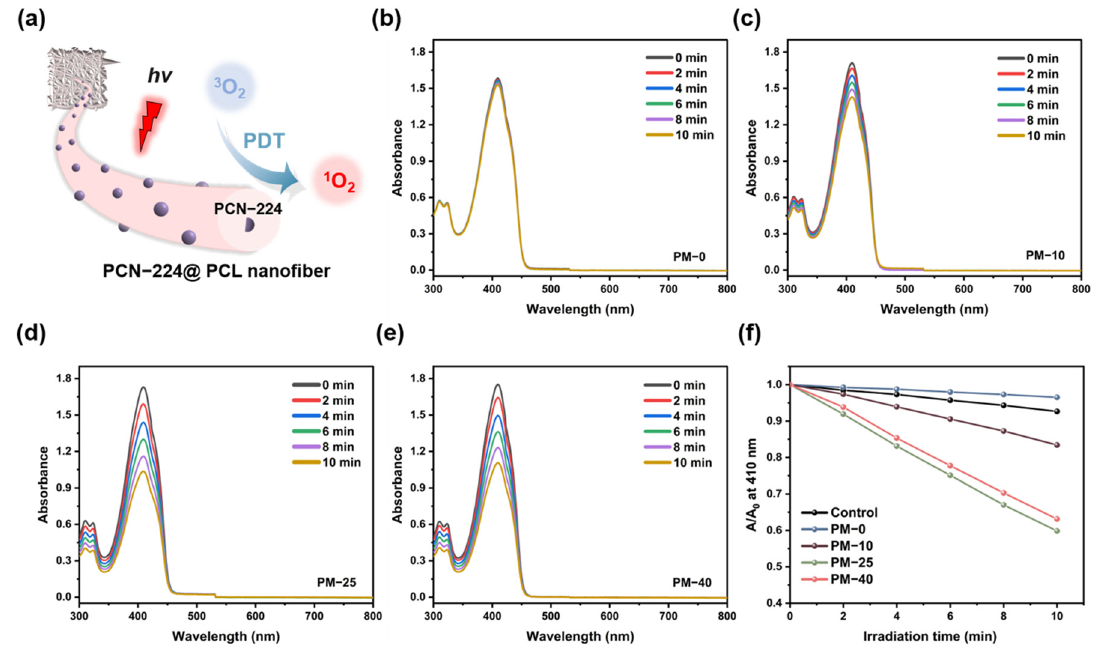
Figure 5. ( a ) The generation mechanism schematic of 1 O 2 by membranes with PCN − 224 NPs introduced. UV-visible spectrum of 1,3-diphenylisobenzofuran (DPBF) under visible illumination (630 nm, 100 mW/cm 2 ) in the present of ( b ) PM − 0, ( c ) PM − 10, ( d ) PM − 25 and ( e ) PM − 40 NFMs. ( f ) The relative absorbance of DPBF solutions was incubated with the membranes at 410 nm as a function of irradiation time.